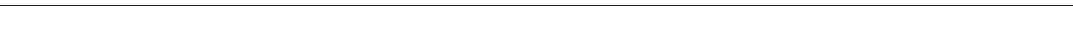
Fig. 3 Effects of thermal acclimation and adaptation on cell size and macromolecular composition. a Cell size (here as µ m diameter) decreased with warming in the ancestor as an acclimation response, but cells became larger at warmer temperatures after 300 generations of evolution. Consequently, carbon ( b ), nitrogen ( c ), and phosphorus ( d ) quotas per cell volume of ancestral samples remained relatively stable up to the ancestor ’ s optimum temperature and then increased, whereas elemental quotas in evolved lineages decreased with temperature (compare also Supplementary Figure 4 for per cell quotas). Protein ( e ) and f RNA content per unit cell volume mirrored the changes in intracellular N and P content respectively. The chlorophyll-to- carbon ratio was also highest in the fastest growing lineages selected under moderate warming ( g ) and the C:N ( h ), N:P ( i ), and C:P ( j ) ratios increased with increasing selection temperature both in the short- and in the long-term, with values in the fl uctuating environment comparable to those in the moderate warming treatment – See Supplementary Information for Φ PSII (Supplementary Figure 3) and silicate content (Supplementary Figure 4). For all panels, n = 6. Boxplots are for the ancestor (gray) and evolved lineages after 300 generations at 22 °C (green), 26 °C (blue), 32 °C (red) and the fl uctuating environment (purple). Whiskers on boxplots indicate 1.5 × interquartile